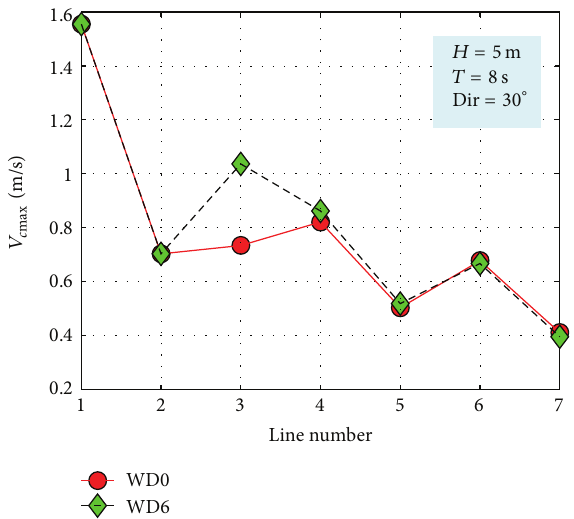
Figure 17: Evaluation of the impact of the energy farms on the maximum velocities of the nearshore currents along the reference lines considered for an additional case study defined by the parameters 𝐻 𝑠 = 5 m, 𝑇 𝑚 = 8 s, and Dir= 30 ∘ .